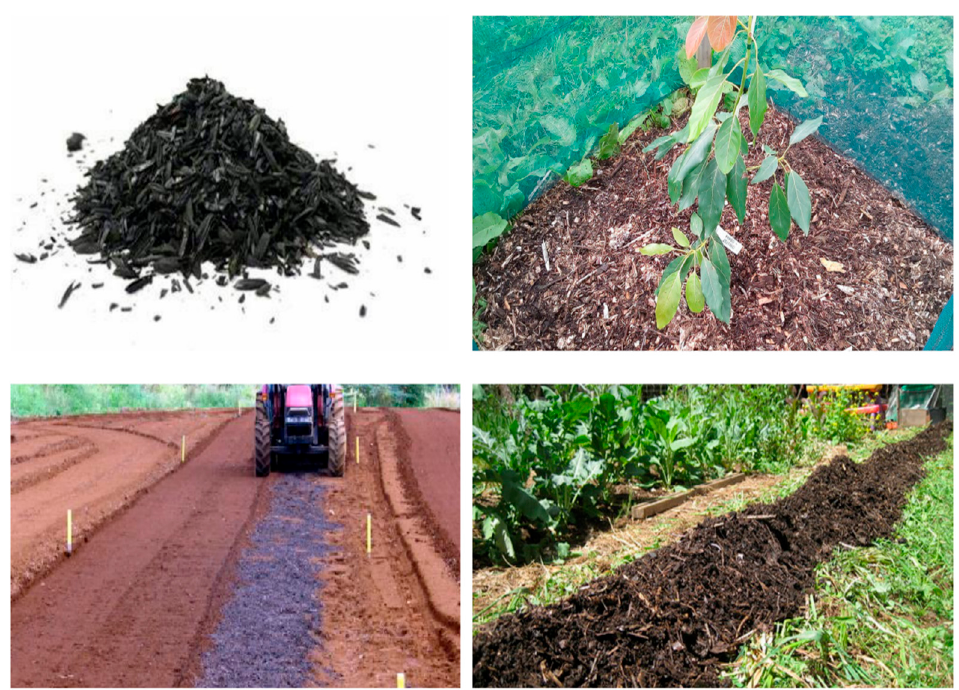
Figure 1. Modified figure of Biochar based sustainable Amelioration of soil figure is adapted from [114–116] with due copyright permission under CC license.